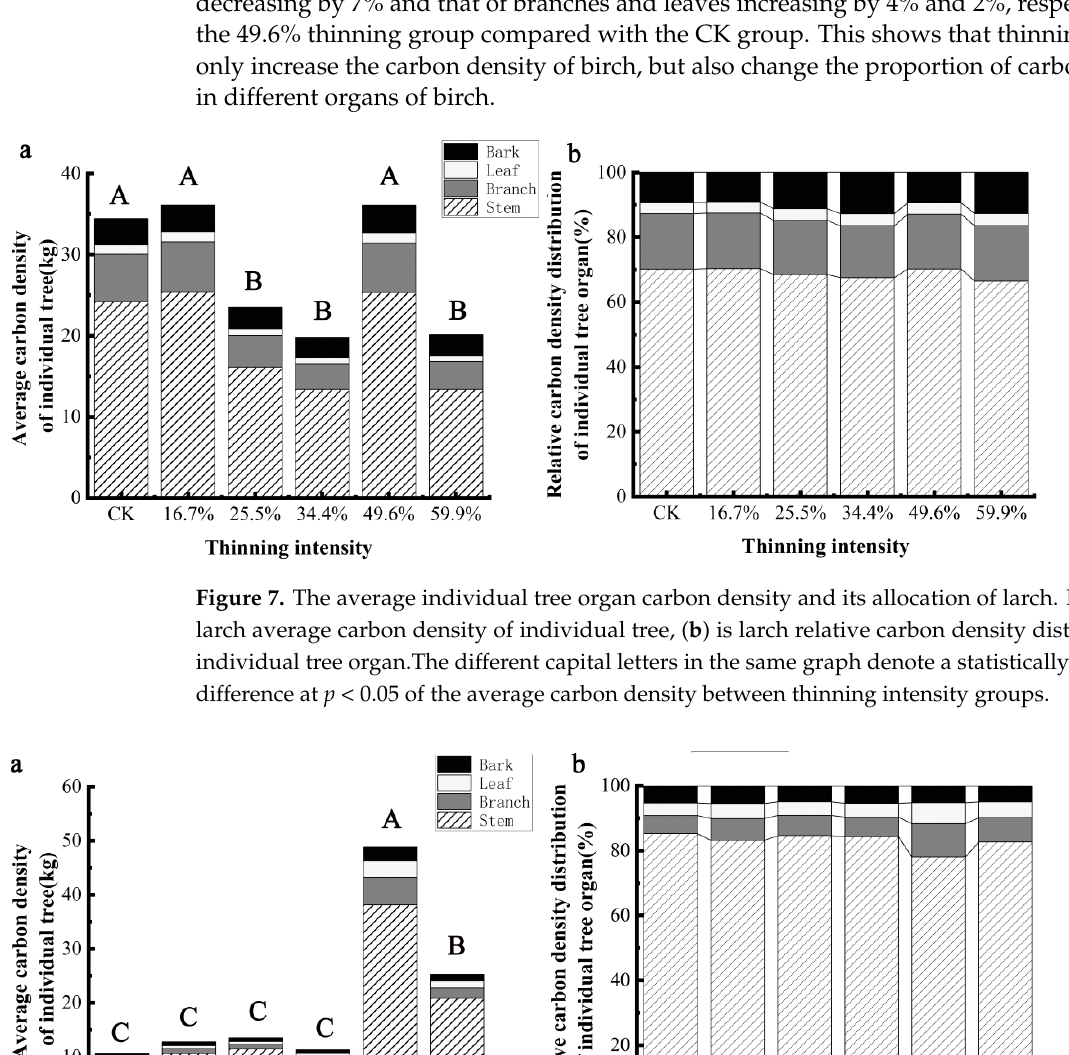
Figure 7. The average individual tree organ carbon density and its allocation of larch. Note: ( a ) is larch average carbon density of individual tree, ( b ) is larch relative carbon density distribution of individual tree organ.The different capital letters in the same graph denote a statistically significant difference at p < 0.05 of the average carbon density between thinning intensity groups.